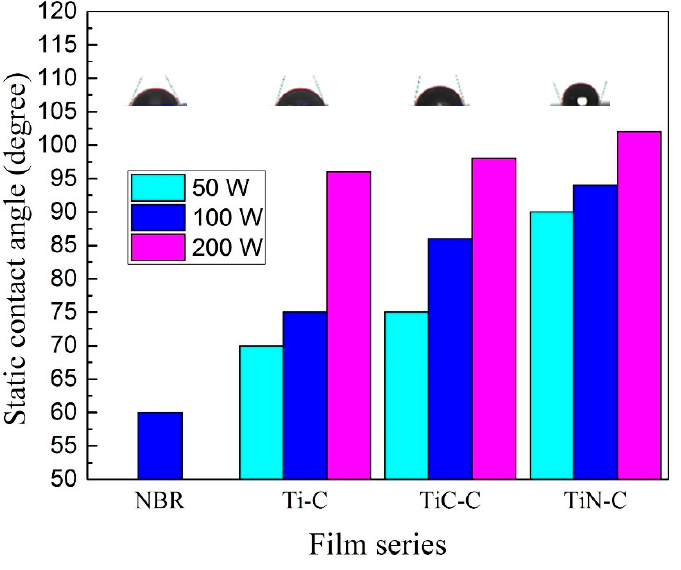
Figure 10. Static contact angle of (Ti:N)-GLC films.